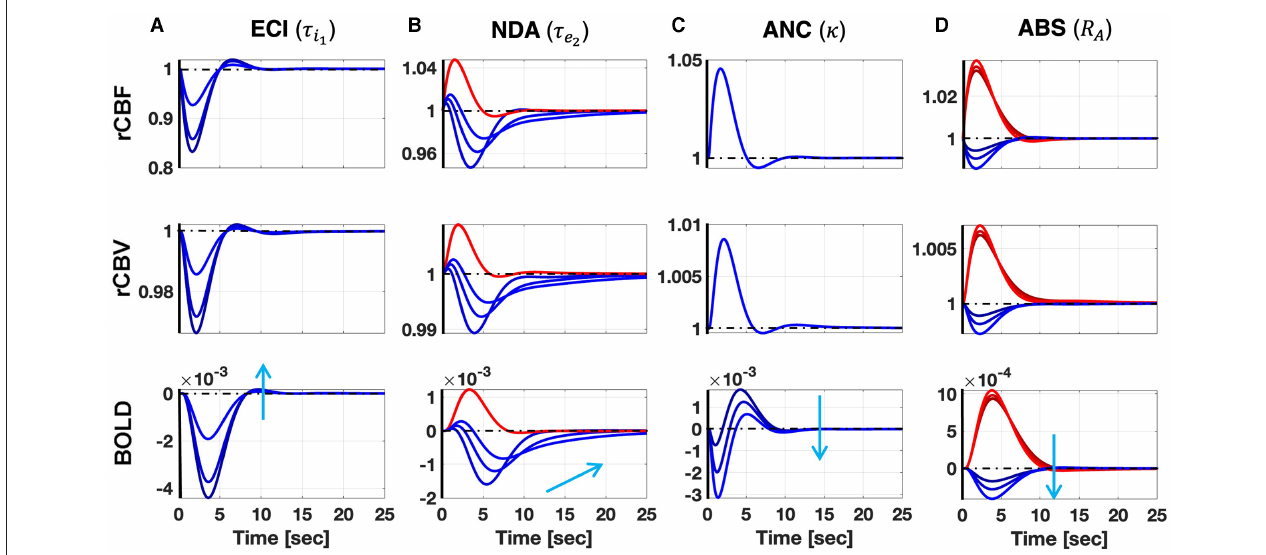
FIGURE 1 | Simulation of the ECI (A) , NDA (B) , ANC (C) , and ABS (D) mechanisms after a single short pulse. Red (blue) corresponds to PBR (NBR). Each column corresponds to variation in a parameter that significantly determines the NBR waveform. The sensibility of the responses to these parameters is illustrated with different curves corresponding to three different values of the parameters covering the ranges in Supplementary Table A3 . The light blue arrow indicates how the NBRs change by increasing the value of the parameters. Besides BOLD responses, we also show other candidate observables in MRI: rCBF and rCBV. Increasing the duration of the inhibitory recovery decreases the amplitude of the ECI mechanism. Expectedly, the longer the recovery time constant in the NDA mechanism, the slower the NBR. We also note that higher neurometabolic coupling gain yields higher NBR amplitudes in the ANC mechanism. Besides, the higher the arterial resistance, relative to the arteriole, in the ABS mechanism, respectively, the higher NBR amplitude. some particular IZs of five patients with refractory focal